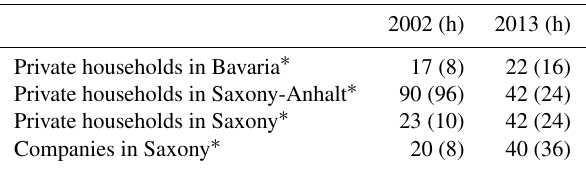
Table 3. Mean (median) lead times indicated by private households and